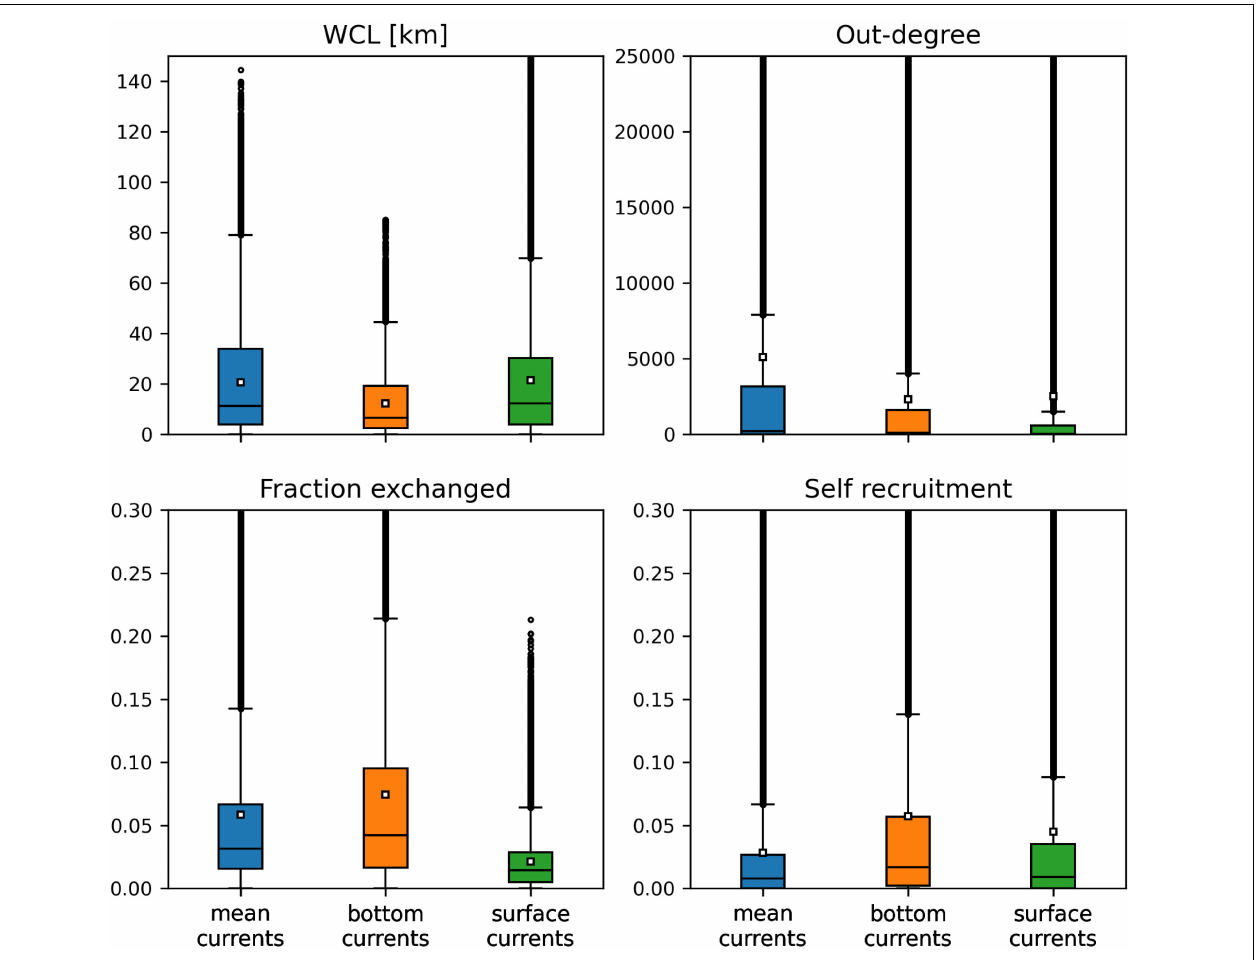
FIGURE 4 | Distribution of the indicators derived from the monthly connectivity matrices computed for each type of current during our simulated period. Mean values are indicated by white squares.